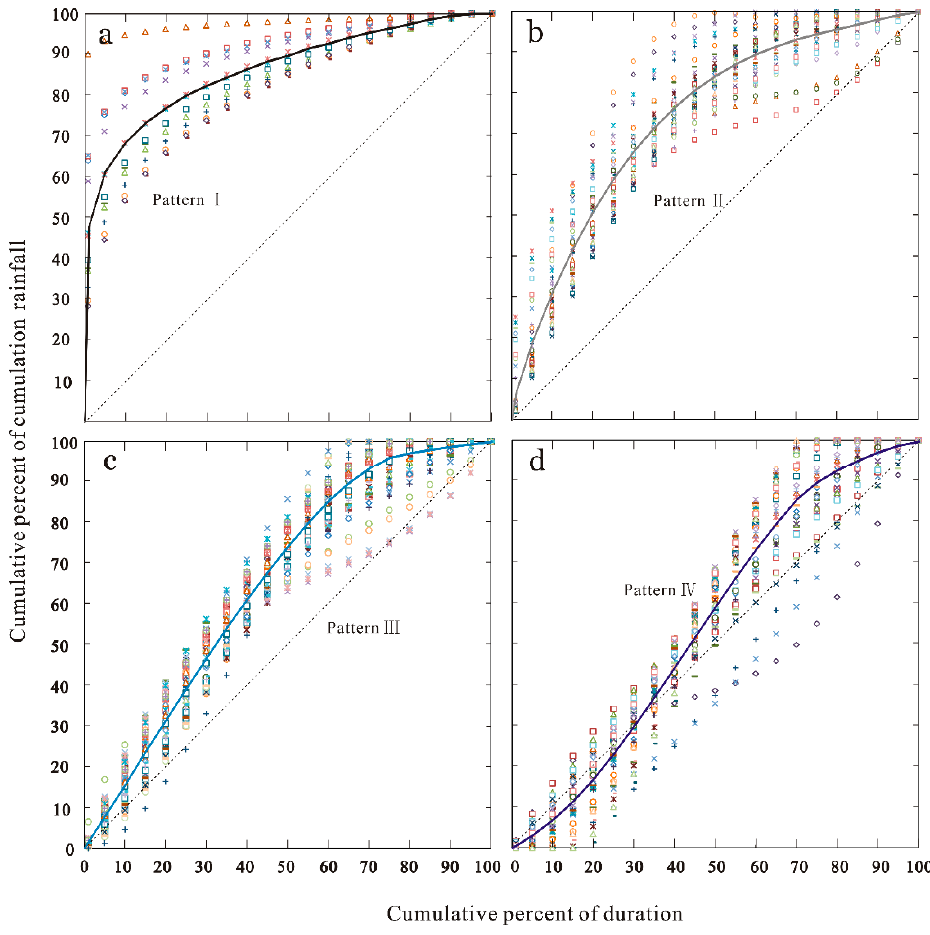
Figure 11. The scatter diagram of rainfall patterns. Four kinds of rainfall patterns including (a) Pattern I, (b) Pattern II, (c) Pattern III, and (d) Pattern IV according to K -value clustering analysis.